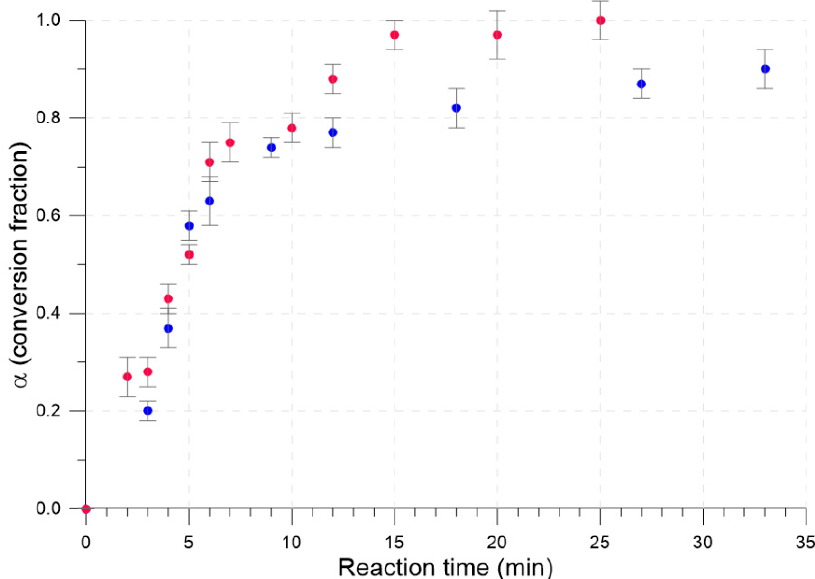
Figure 5. The isothermal reaction kinetic profiles for: ( a ) the neat mechanochemical synthesis of TTF-CA (blue circles), and ( b ) the LAG synthesis with diethyl ether, η = 1 µ L / mg (red circles). The error bars in α graphically represent the ∆ α values of Tables 1 and 2, respectively.